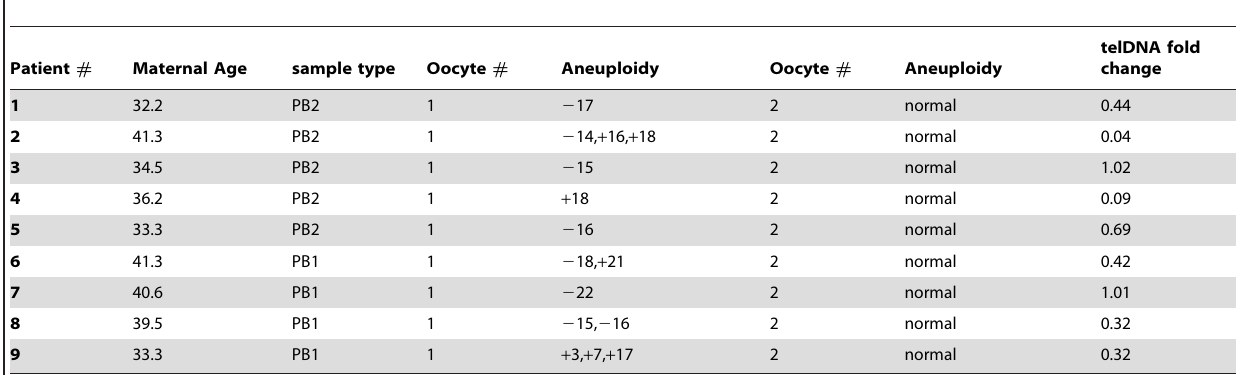
Table 1. Polar body samples evaluated by microarray based aneuploidy screening and relative telomere DNA quantitation.